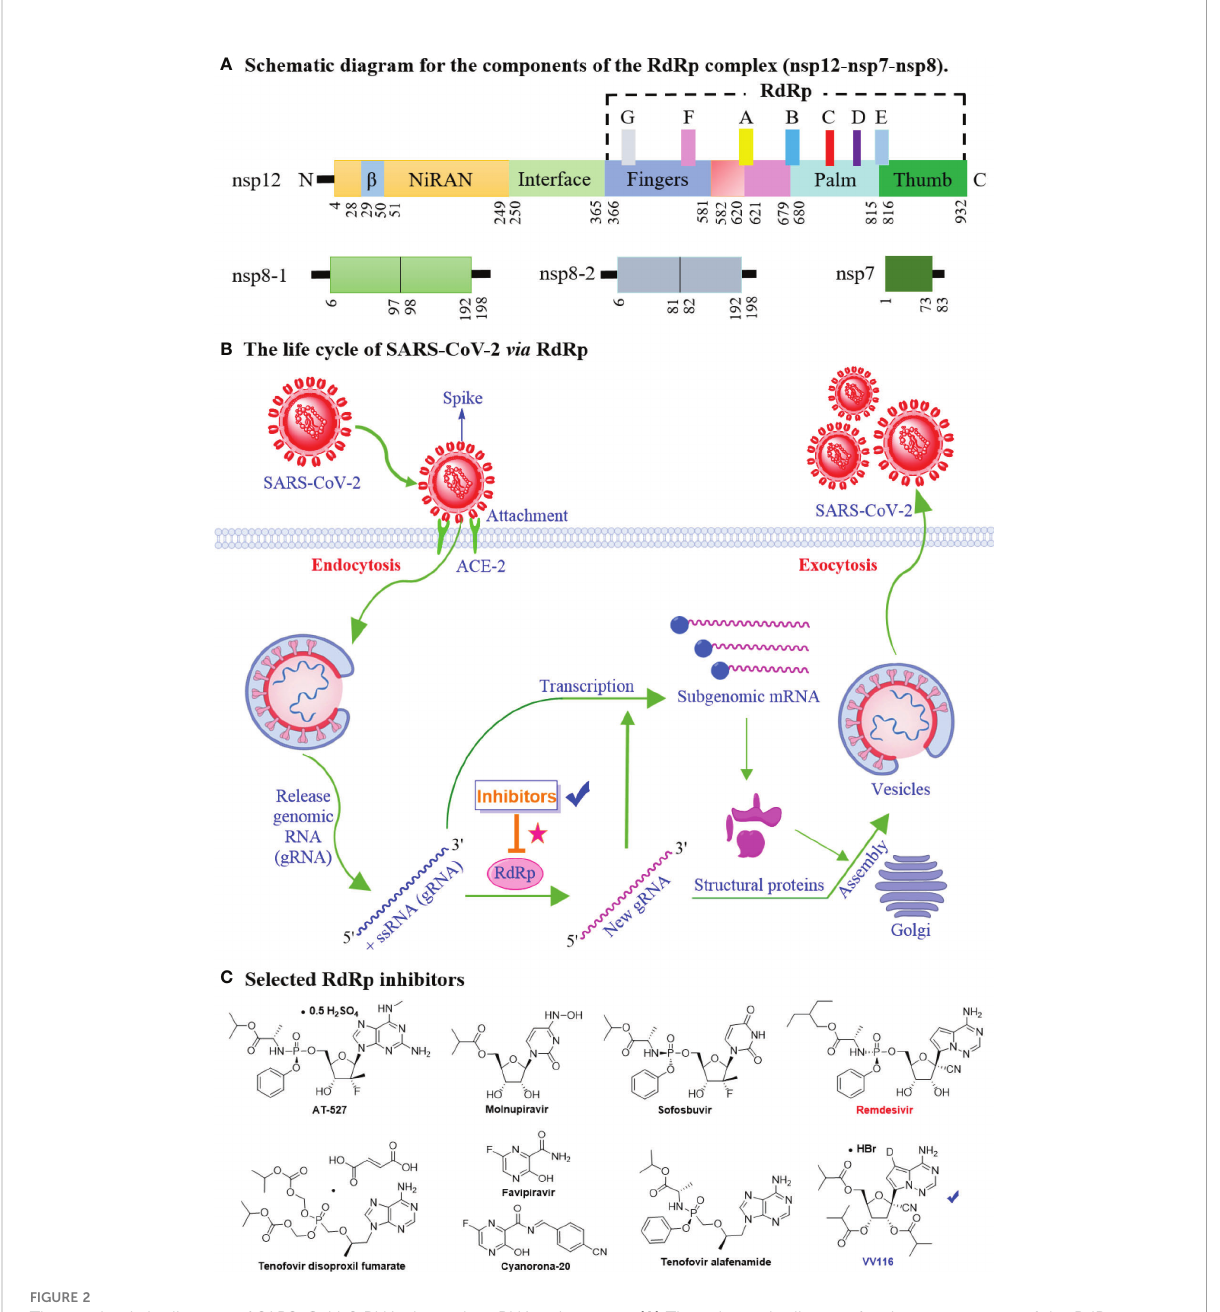
FIGURE 2 The mechanistic diagram of SARS-CoV-2 RNA-dependent RNA polymerase. (A) The schematic diagram for the components of the RdRp complex, containing nsp12, nsp8 and nsp7. The polymerase motif (A to G) and the b hairpin are highlighted. (B) The life cycle of SARS-CoV-2 via RdRp. The life cycle of SARS-CoV-2 involves sequential viral entry into the target cell, uncoating, replication and transcription, protein synthesis, and viral assembly and release. The RdRp is involved in SARS-CoV-2 genomic and subgenomic mRNA synthesis. (C) Chemical structures of selected SARS-CoV-2 RdRp inhibitors ( AT-527, Molnupiravir, Sofosbuvir, Tenofovir disoproxil fumarate, Favipiravir, Cyanorona-20, Tenofovir alafenamide, Remdesivir, and VV116 ) for COVID-19